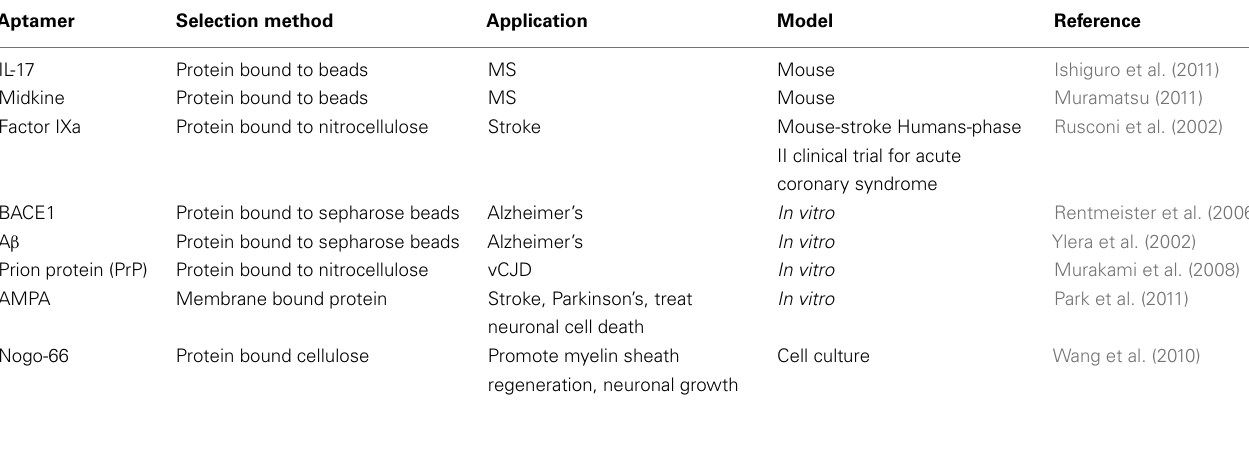
Table 2 |Therapeutic RNA aptamers for treatment of neurological